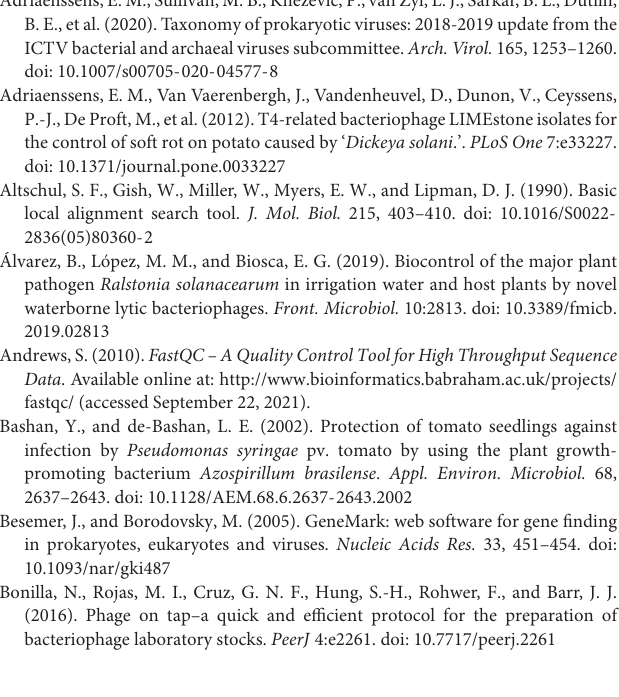
Supplementary Table 2 | Predicted ORFs and their functional annotation in the genome of Pseudomonas phage Eisa9. Putative Shine-Dalgarno sequences